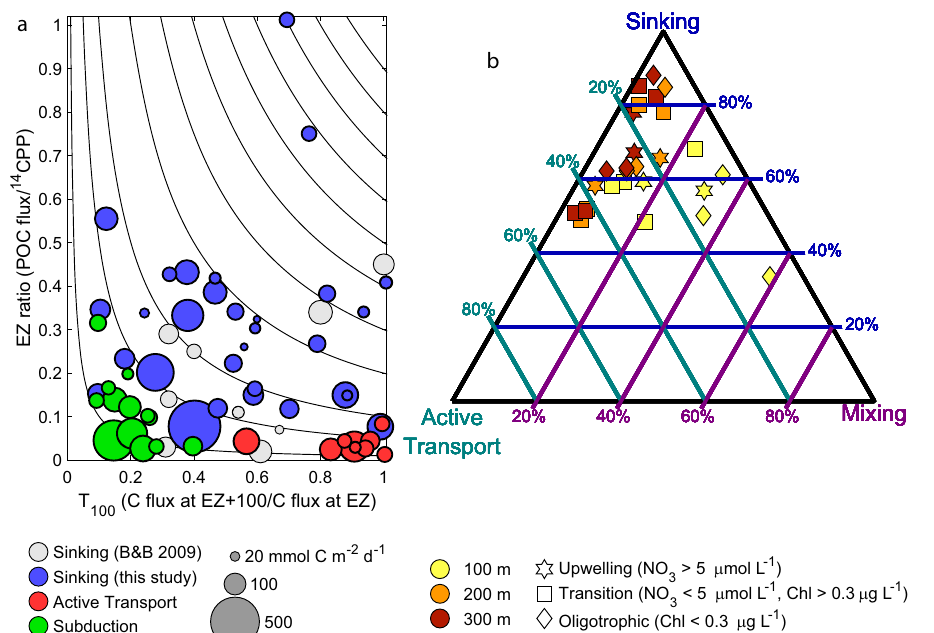
b Triangle diagram showing the proportionof export due to eachbiological carbon pump(BCP)pathwayatdifferentdepthhorizonsfollowingref.80.Symbolsnearthe top vertex indicate sinking dominated export; symbols near the bottom left are dominated by active transport; bottom right are mixing. Note that panel ( b ) shows data only from Lagrangian experiments with simultaneous measurements of all three pathways. Source data are provided as a Source Data fi le.